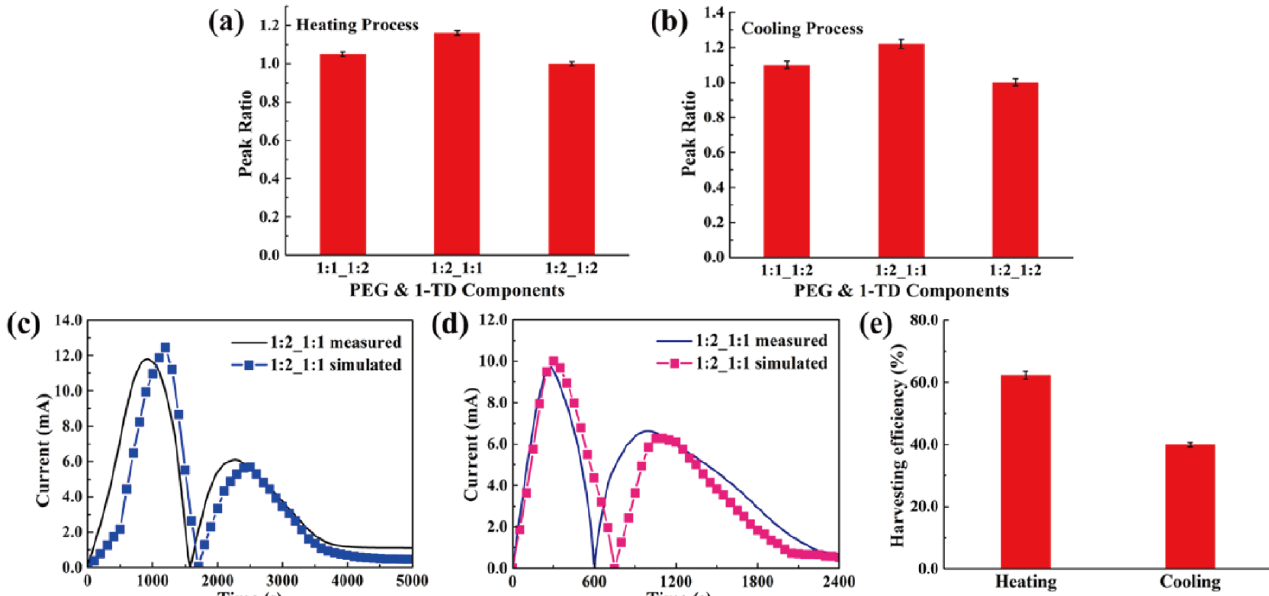
Figure 13. Peak ratios of PCM composites during the ( a ) heating process and ( b ) cooling process. Experimental current and numerical calculation during the ( c ) heating process and ( d ) cooling process. ( e ) Thermoelectric energy harvesting efficiency.